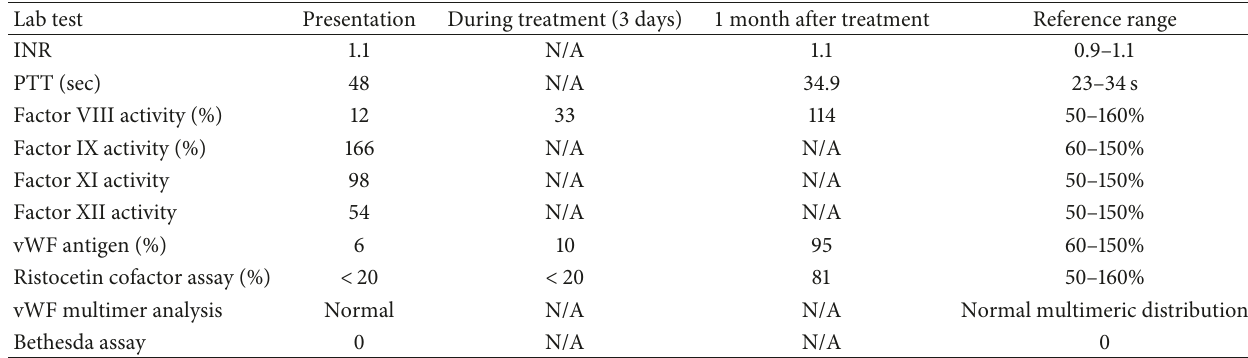
Figure 1: CT scan of the abdomen with retroperitoneal hematoma. Table 1: Lab tests done during presentation, treatment, and a month after